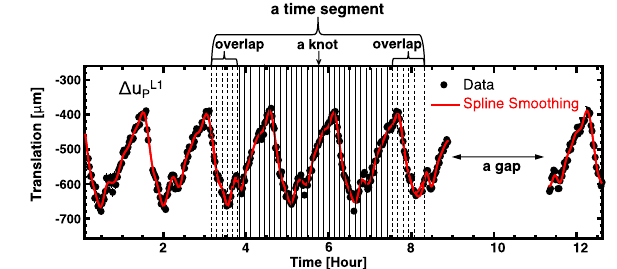
Fig. 13 Illustrationofthesplinesmoothingfordescribingthevariation over time. The entire time of the dynamic alignment parameter Δ u L 1 P block is divided into several smaller overlapping time segments, where the alignment data (points) in each segment are smoothed by a spline function (curve) as indicated. The distribution of knots of the spline is indicated by the vertical lines including those knots shared with the neighboring splines (dashed vertical